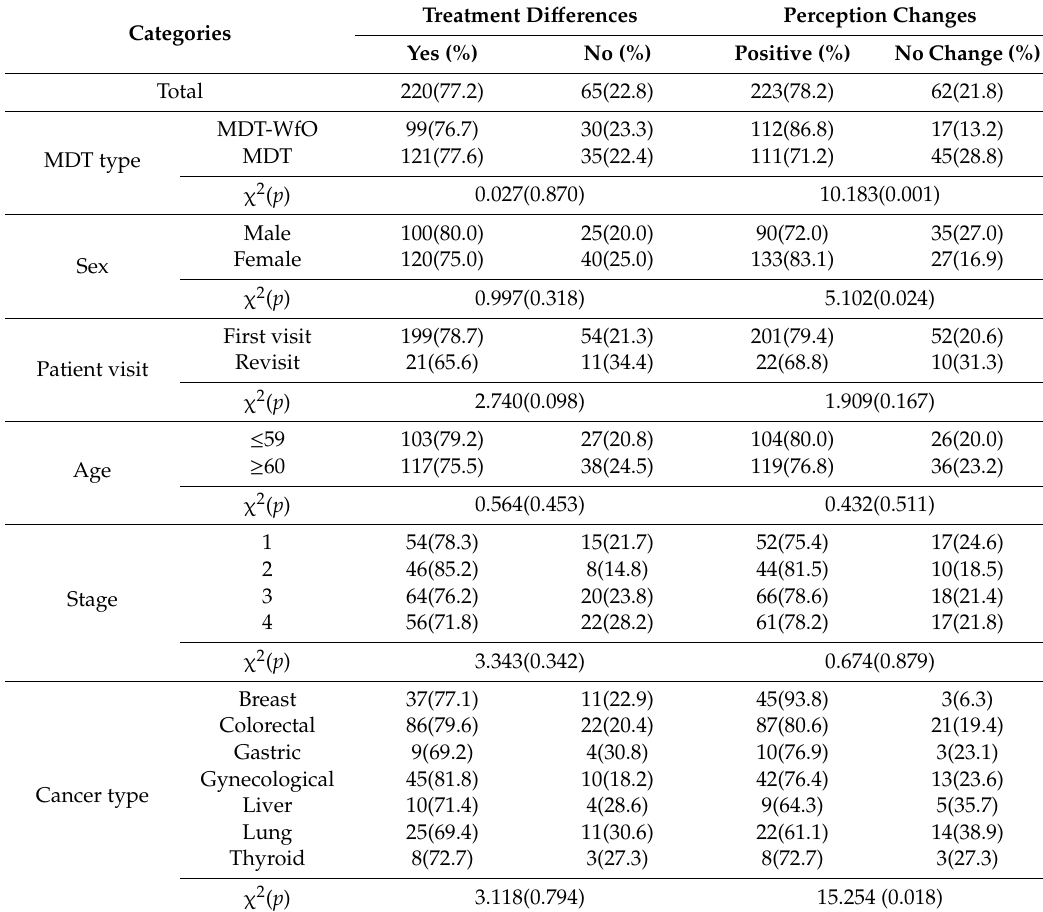
Table 2. Di ff erence from general treatment and changes in patient perception of the